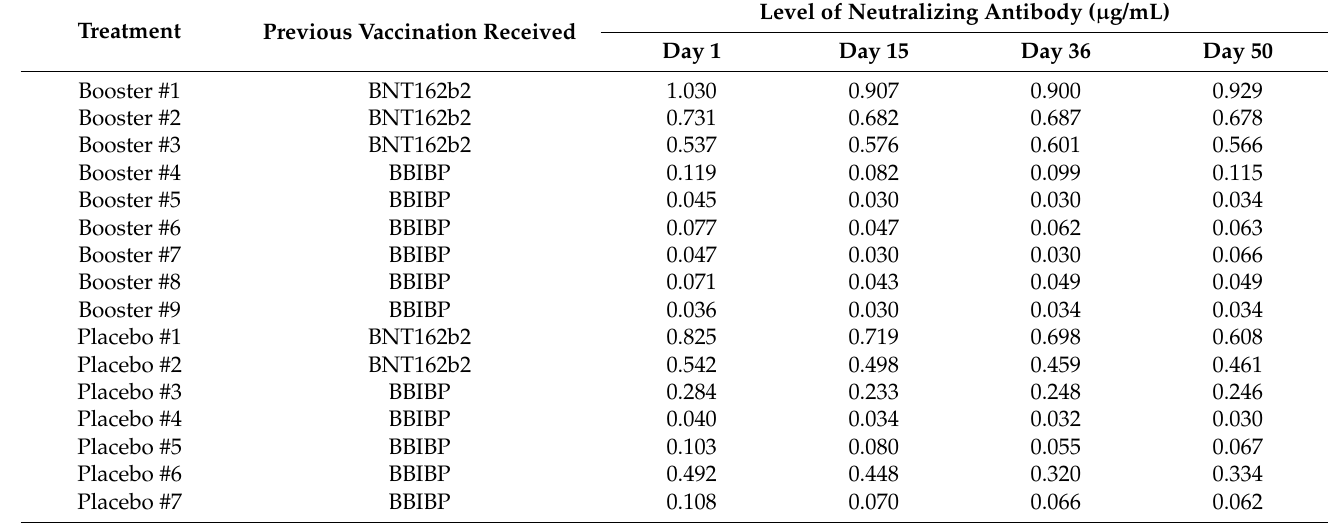
Table 1. Levels of neutralizing antibody in all participants over time.